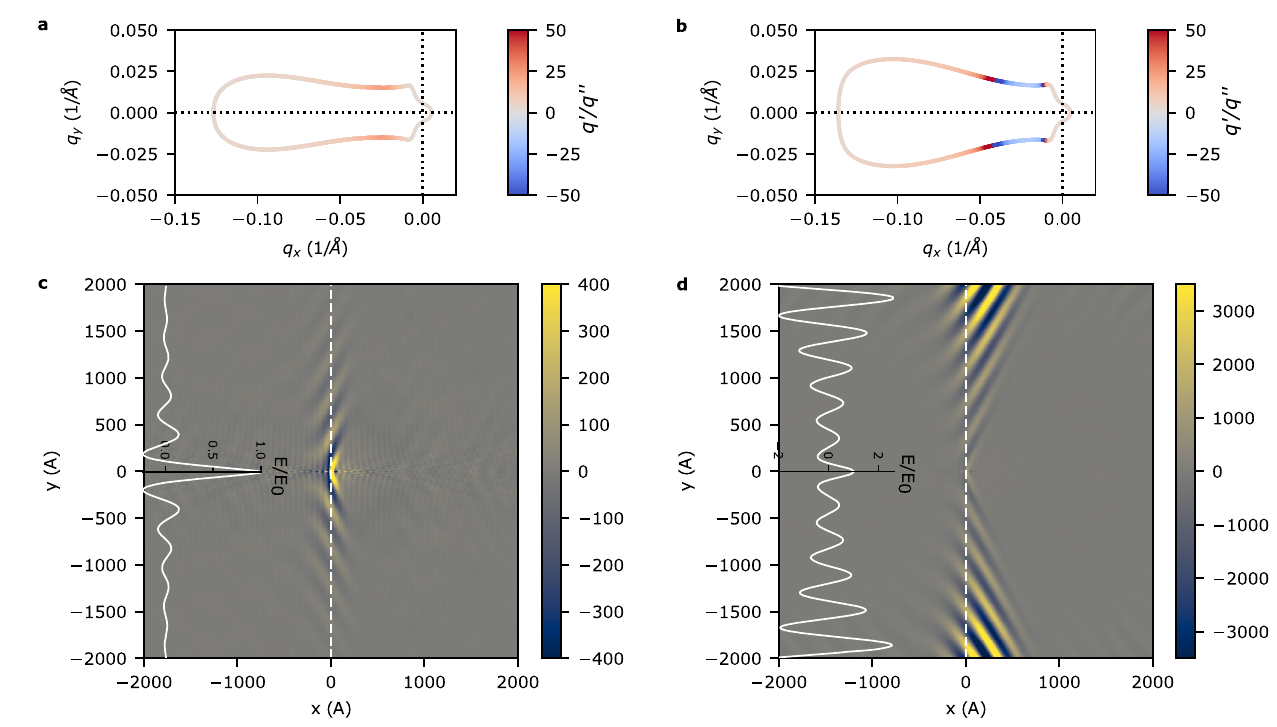
Fig. 5 | Fields excited by a point dipole. a , b Isofrequency curves at ℏ ω =0.16eV for drift velocity u / v =0.37 and u / v =0.41 respectively. c , d Fields generated by eq. (3) for isofrequency curves Fig. 5a and b respectively. The solid white inset